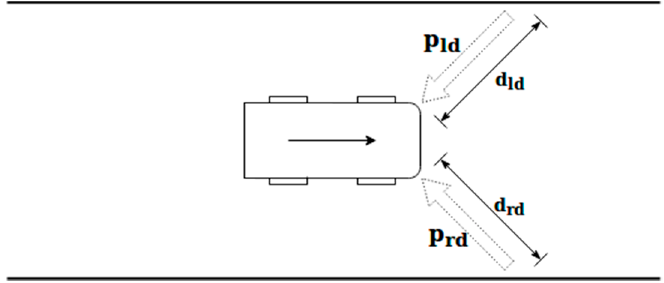
Figure 5. Scheme for the diagonal potential field calculation.